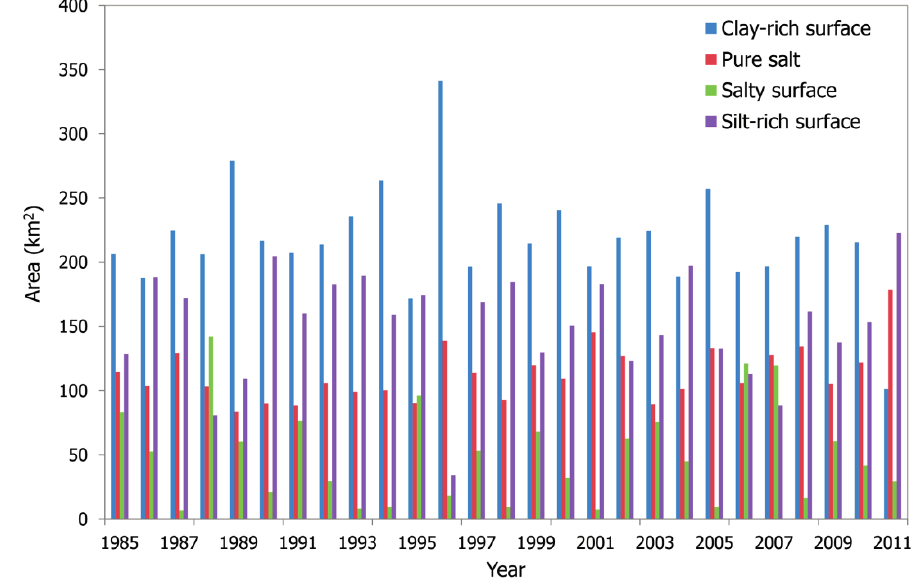
Figure 8. Areal statistics of each class between 1985 and 2011.